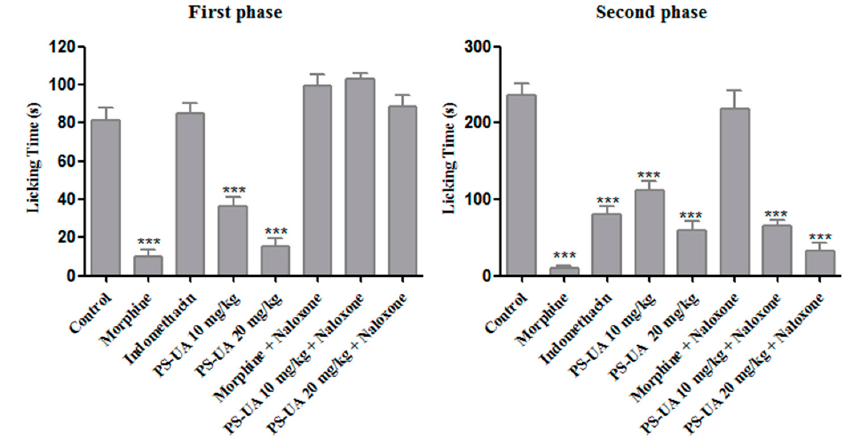
Figure 5. The antinociceptive e ff ect of PS-UA (10 and 20 mg / kg; oral administration) and the reference drugs, indomethacin (20 mg / kg; intraperitoneal) and morphine (10 mg / kg; oral administration), in both phases of the formalin assay. The bars represent the mean time spent by the mice licking their paws ± SD. The involvement of opioid receptors in the antinociceptive e ff ect was also evaluated by administering naloxone (5 mg / kg, intraperitoneal) to the mice 30 min before the administration of PS-UA or morphine. (***) indicates significant di ff erence ( p < 0.001) in the licking time versus the control. Opioid and non-opioid analgesics are the mainstay of pain management. Antidepressants,